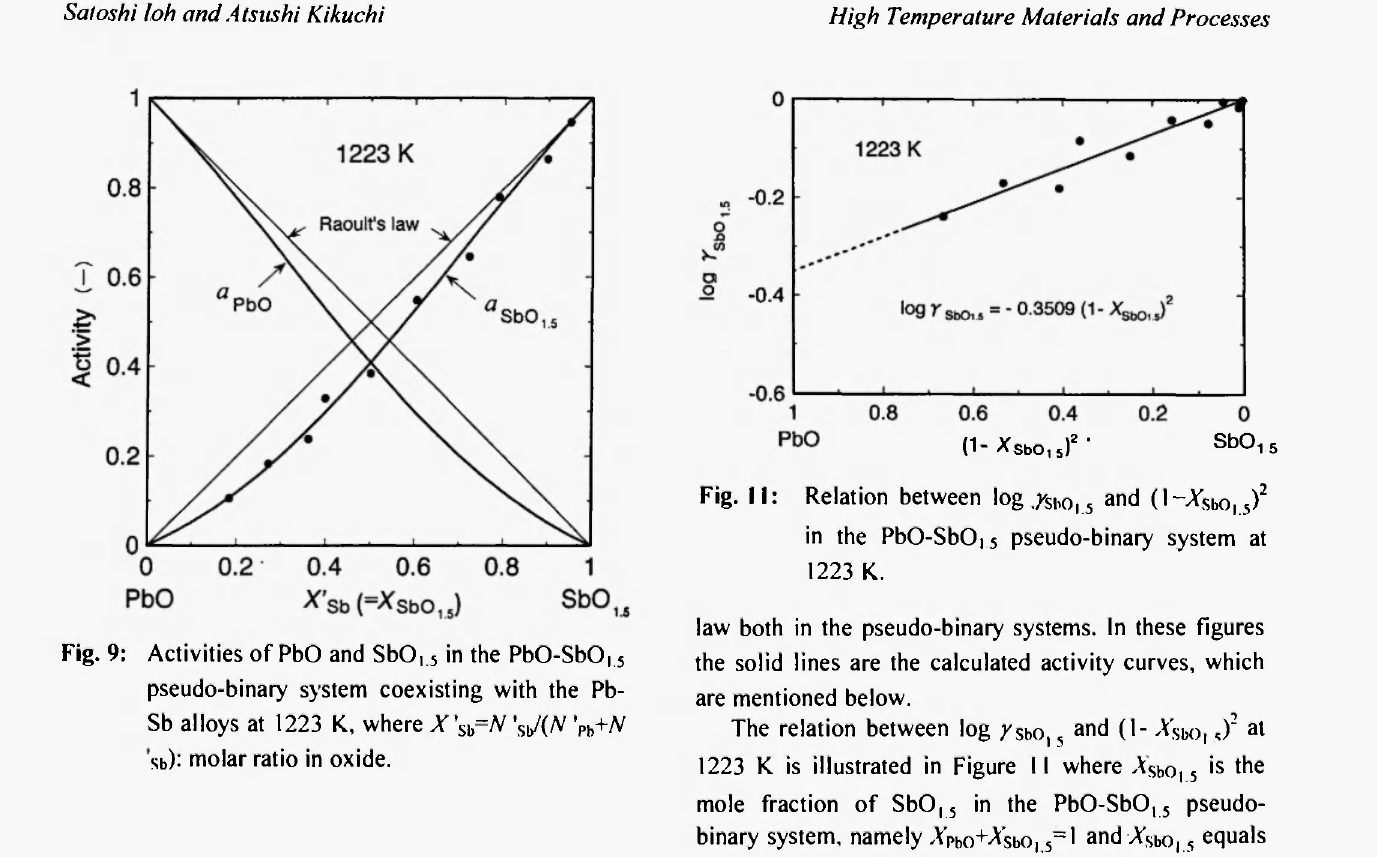
Fig. 9: Activities of PbO and SbO, 5 in the PbO-SbO, 5 pseudo-binary system coexisting with the Pb- Sb alloys at 1223 K, where X' Sb =N ' Sb /(N Vi ,+N sb): molar ratio in oxide.